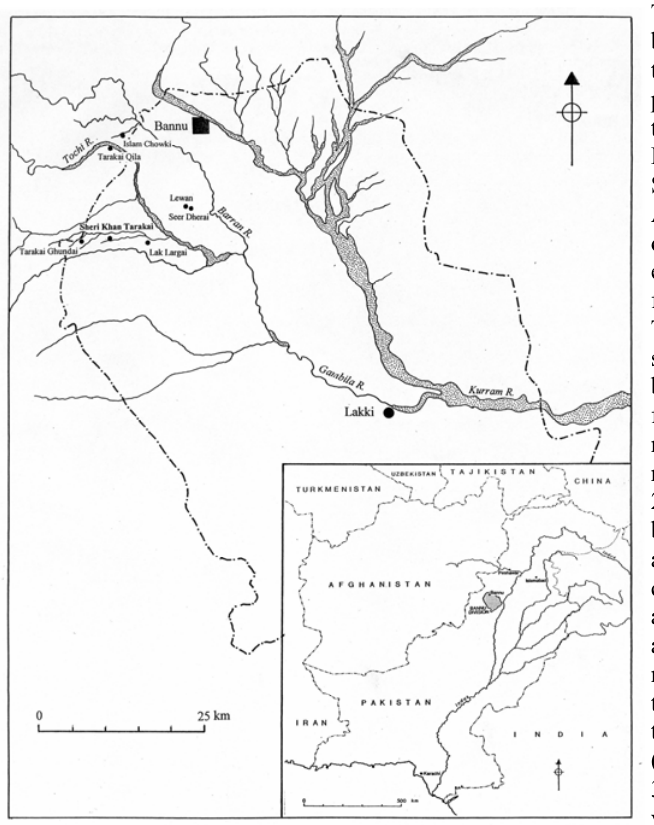
Figure 1. Fourth to third millennium sites in the Bannu